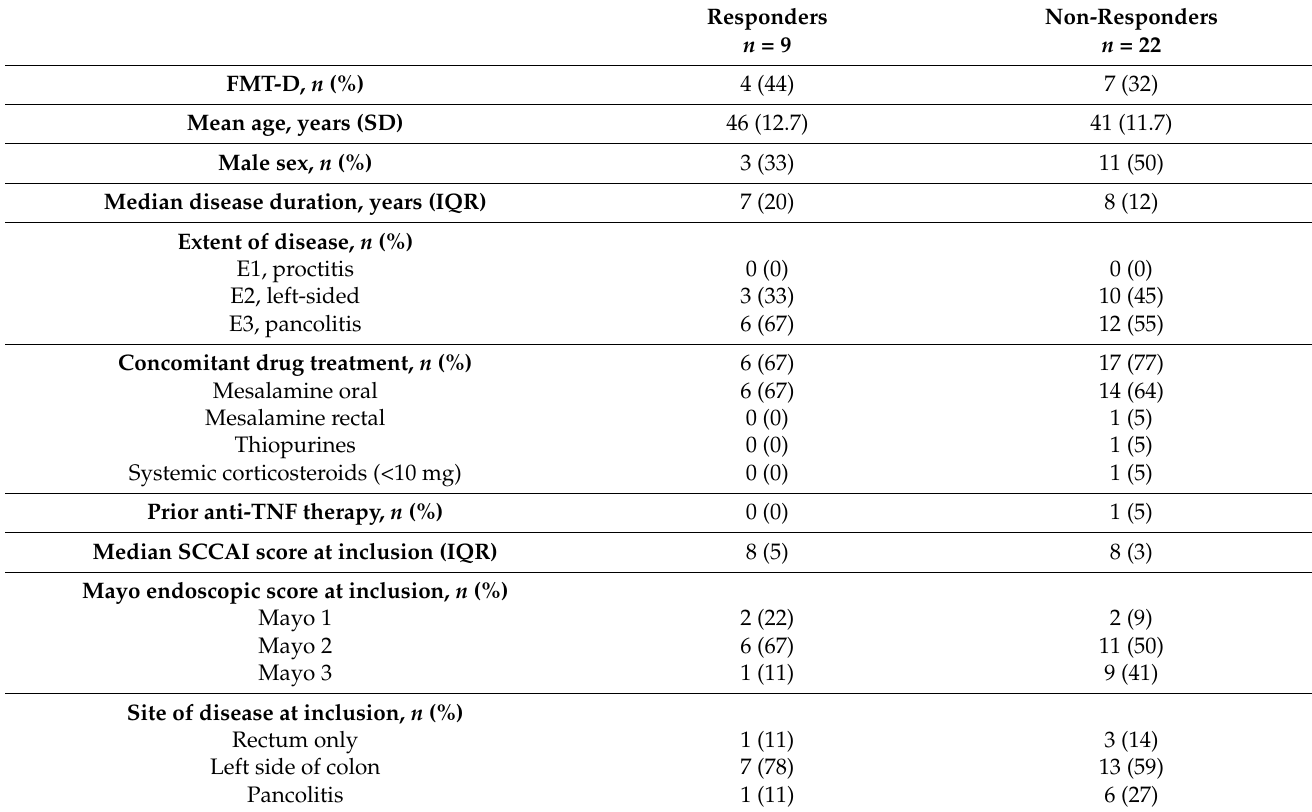
Table 1. Patient baseline characteristics stratified for positive response to fecal microbiota